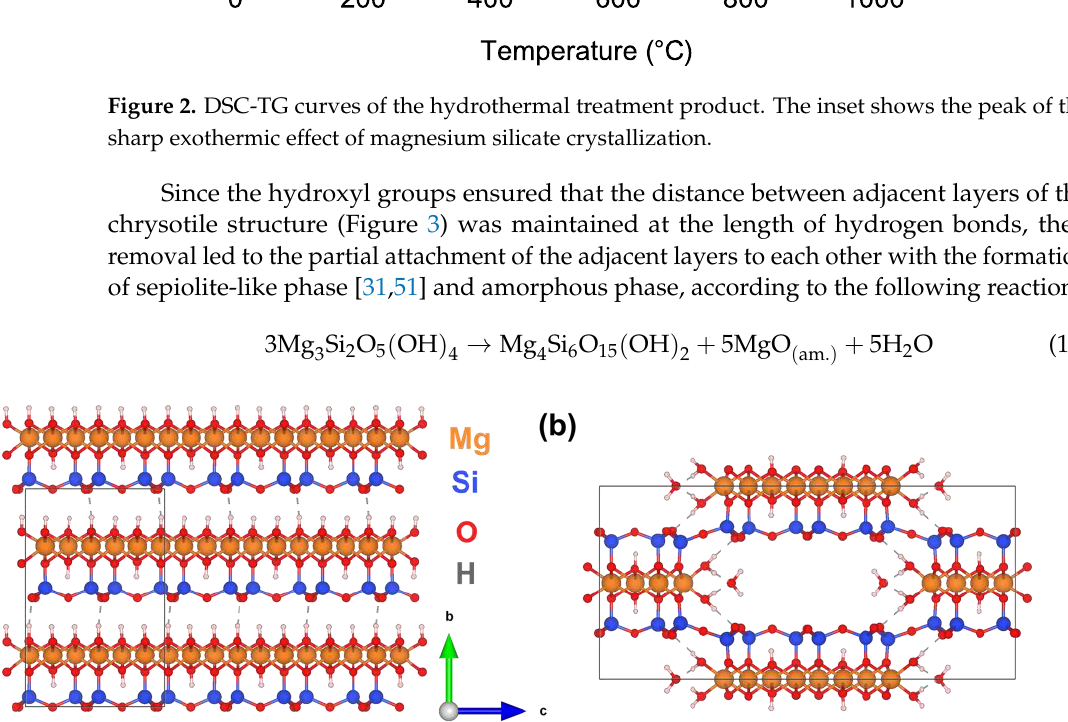
Figure 4. X-ray diffraction patterns and phase analysis of hydrothermal treatment products after drying at 90 °C and after heat treatment at 400 and 600 °C. Phase analysis was carried out using the ICDD PDF-2 database. 3.2. Alteration of Individual Nanobridge Parameters Figure 1 shows an example of AFM data obtained from a nanoscroll exposed to heat treatment. It can be seen that, because of thermal treatment, the fitting parameter 𝛽 de- creased, while the corrected value of Young ’ s modulus, on the contrary, increased. The heat treatment of the substrate with each sample led to a change in both the size parame- ters and mechanical characteristics of the nanoscrolls. Figure 5 shows the tracks of the main characteristics of nanobridges. The bending stiffness of nanobridges increased rela- tively weakly with increasing treatment temperature, while the outer diameter (included in Equation (8) as 𝐷 −4 ) decreased due to the dehydroxylation of the outer surface and nanoscroll walls.